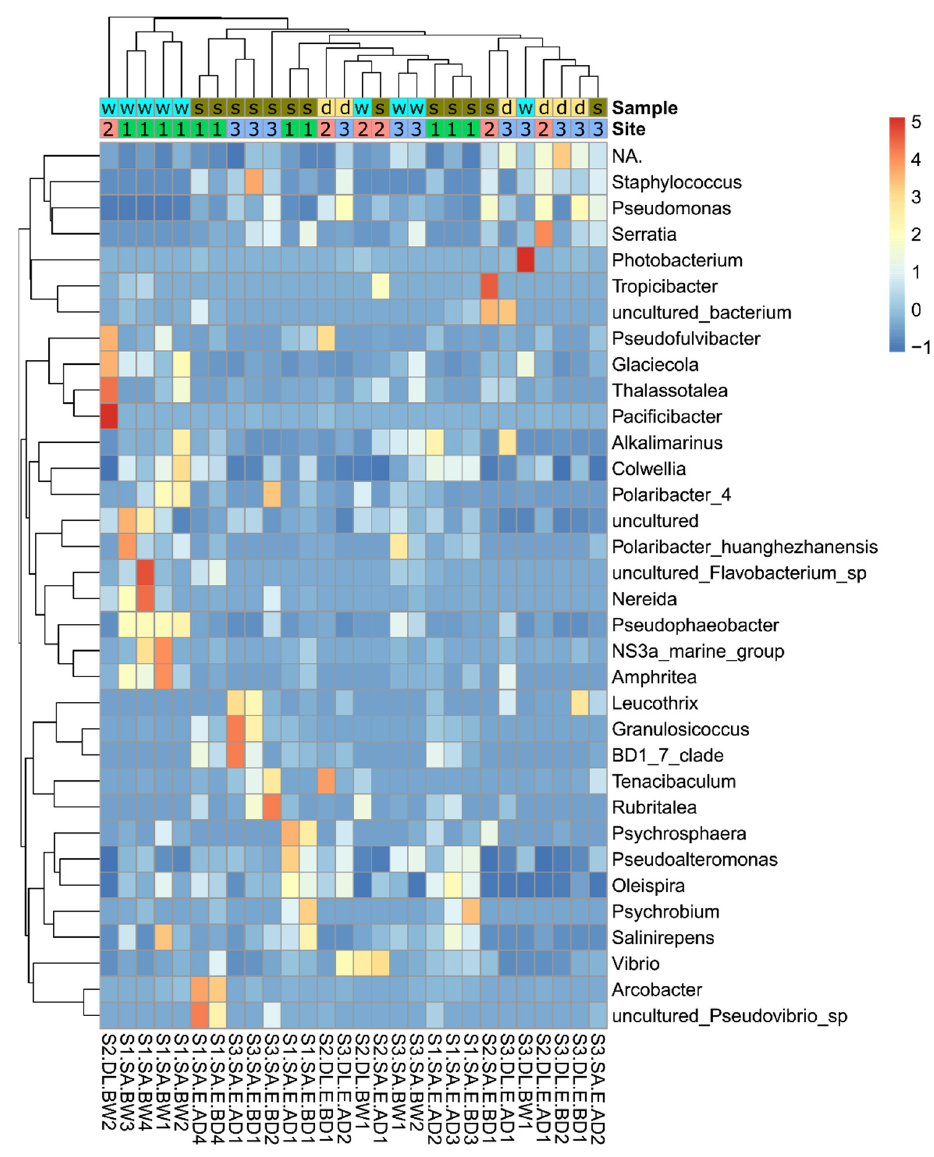
Figure 8. The heatmap of top bacterial genera across eggs and broodstock holding water. Sample: gilthead seabream (s), European seabass (d), water (w); site: site 1–3. Supplementary Materials: The following are available online at https://www.mdpi.com/article/ 10.3390/microorganisms9112275/s1, Table S1. Sequencing statistics of the 28 libraries prepared from European seabass and gilthead seabream eggs before and after disinfection and from broodstock water. More information about the sample labels is provided in Figure 1. Table S2. Bacterial composition and their relative abundance in each of the samples. A total of 294 OTUs were selected, using as the criteria their presence at >1% relative abundance in the 28 samples studied. NA means that the OTU at the taxonomic level was not identified through comparison with the SILVA database. Table S3. The top 15 genera detected in each egg and water sample. The relative percentage of each genus was calculated in relation to all detected genera in each sample. Information on sample labels is provided in Figure 1. Table S4. Differential abundance analysis of microbiota of eggs and water using three factors: Site (Site 1, Site 2, Site 3), type of sample (egg vs. water), and species (European seabass vs. gilthead seabream). OTUs with significantly differential (relative) abundance are presented in different Excel sheets in the table for site, broodstock water, egg, and species. The R package ALDEx2 (1.20.0) was run to identify the OTUs that were differentially abundant across the conditions tested. The centered log-ratio-transformed values were analyzed with a general